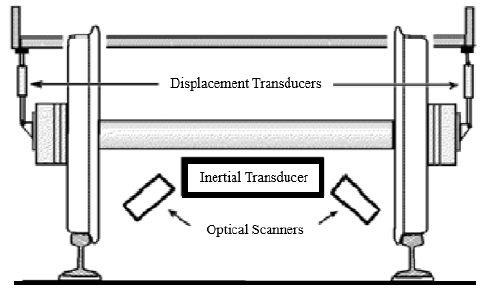
Figure 1. Track recording vehicle measuring system (adapted from Figure 1 . Track recording vehicle measuring system (adapted from [21]).